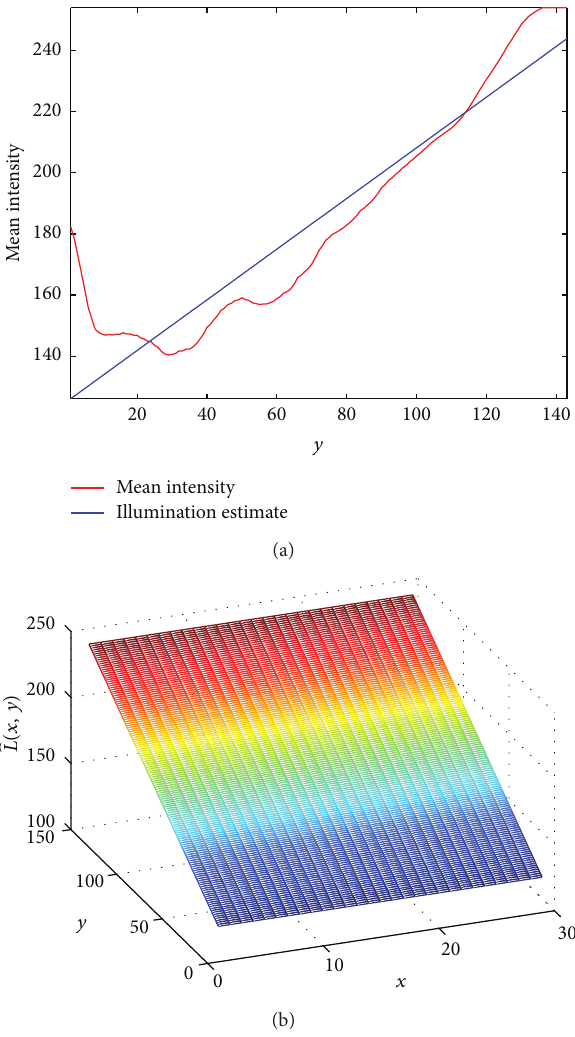
Figure13:(a)Meanintensityalongthecenterverticallineinmasked HSV and estimated illumination line. (b) Estimated illumination ̂𝐿(𝑥,𝑦) function,